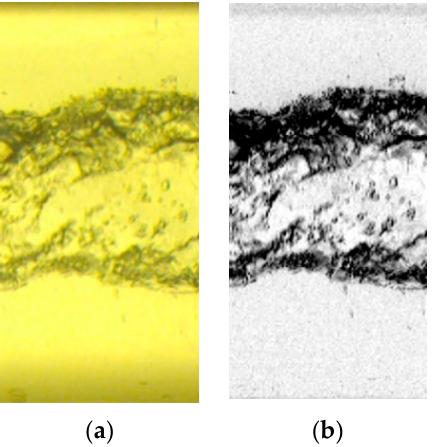
Figure 10. Pre-processing of the flow images. ( a ) Cropped box from the original picture. ( b ) 8-bit contrast-enhanced result.